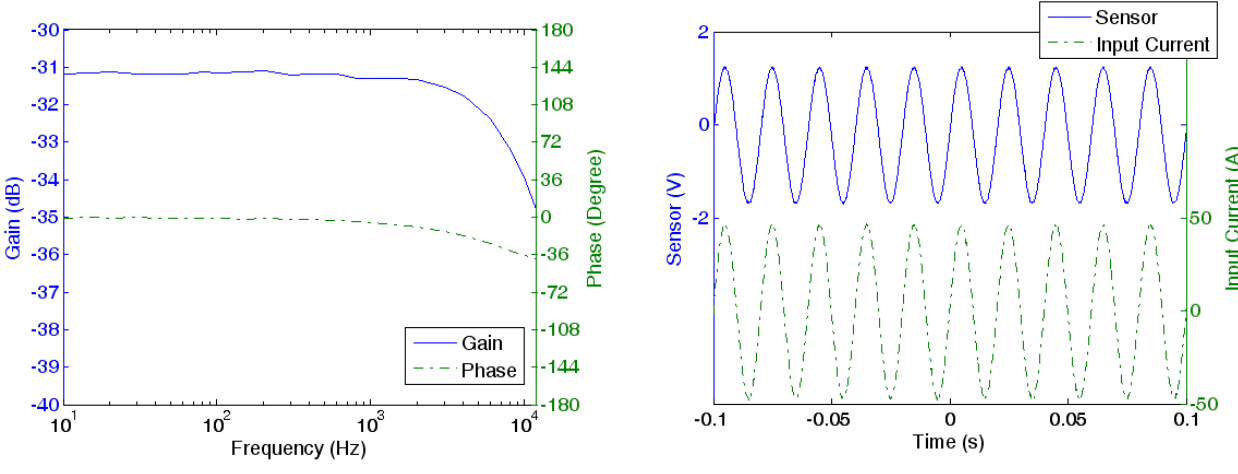
Figure 8. ( a ) Frequency response of the sensor; ( b ) waveform of the input current and the output of sensor at 50 Hz.